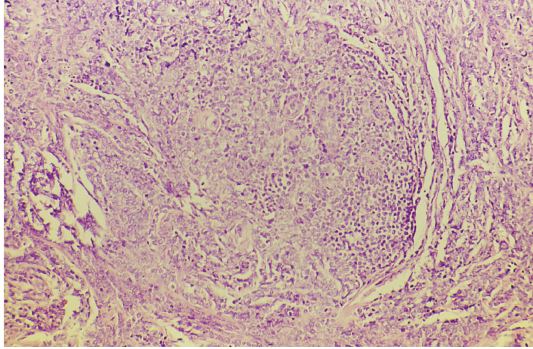
Figure 2: Neoplastic population basically formed by blasts.